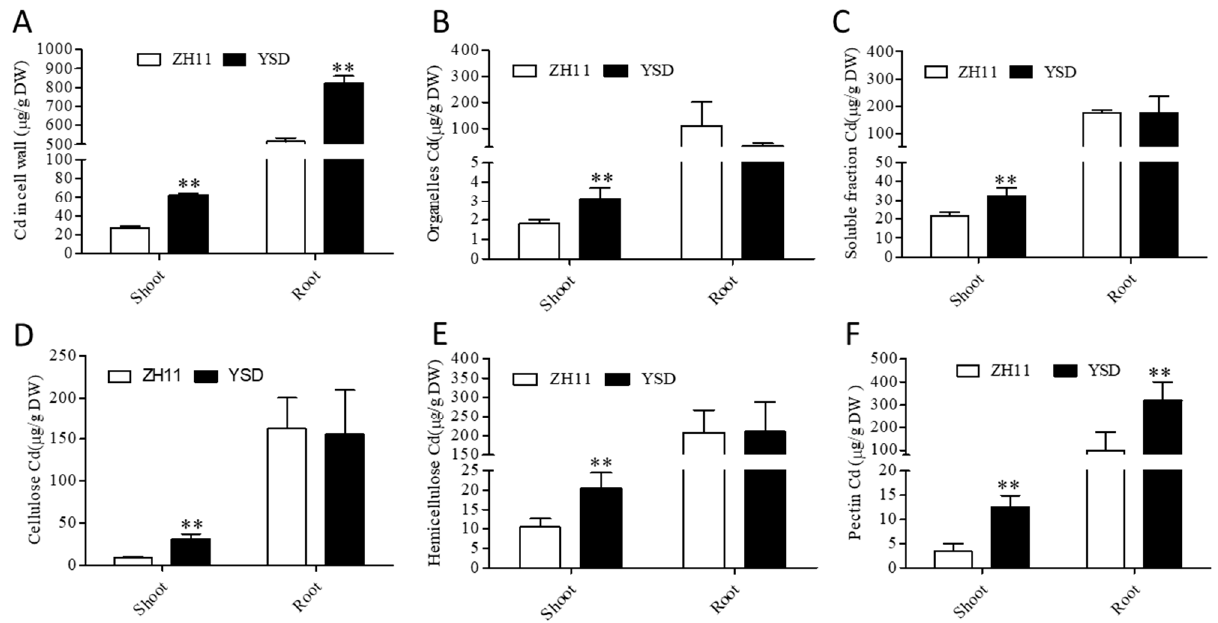
Figure 3. Cd content in different subcellular and cell wall components of YSD and ZH11. After 4 weeks of hydroponics, rice seedlings were treated with 10 μ M Cd for 3 days, Cd content in cell wall ( A ), organelles ( B ), soluble part ( C ), cellulose ( D ), hemicellulose ( E ), and pectin ( F ) of the shoot and root were determined by ICP-MS. Data are presented as the means (±SD), n = 3. Significant differences were determined using the Student’s t -test: ** p < 0.01.